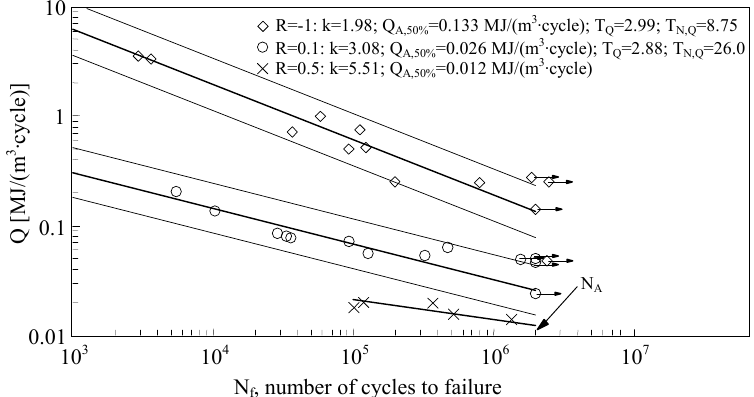
Figure 6: Fatigue data analysed in terms of energy released as heat by a unit volume of material per cycle. Scatter bands are defined for 10 and 90% survival